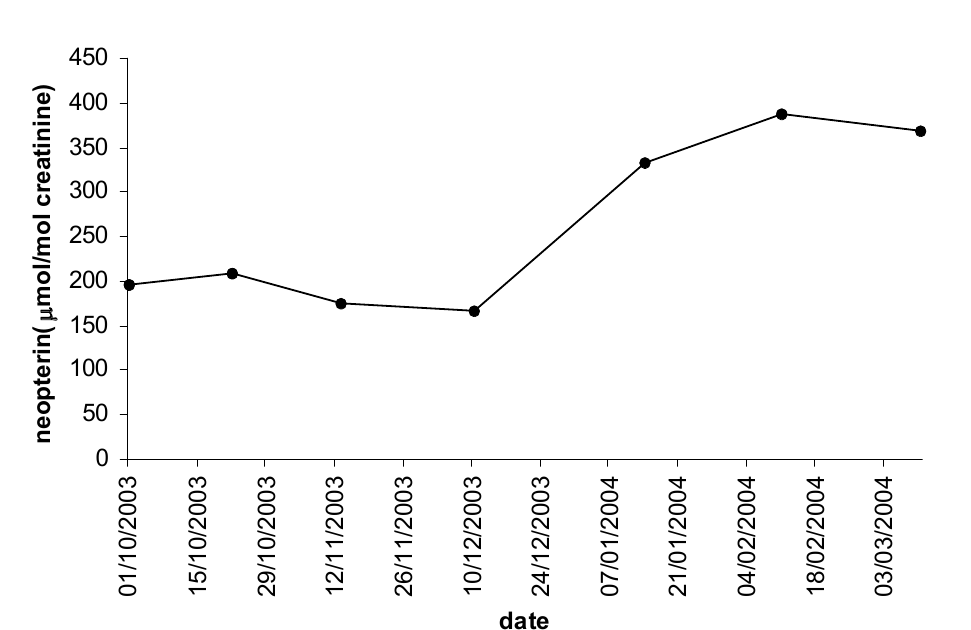
Figure 2. The course of urinary neopterin during gefitinib therapy in a patient with head and neck carcinoma. A 50-year-old male with squamous cell carcinoma of the head and neck recurrent after surgery, radiotherapy and chemotherapy with paclitaxel/carboplatin was treated with gefitinib 500 mg/day. The therapy was started in October 2003. A severe acneiform rash was noted in December 2003 that was later accompanied by purulent skin infection and an increase of urinary neopterin. Tumor progression was evident later in the course of the disease (in May